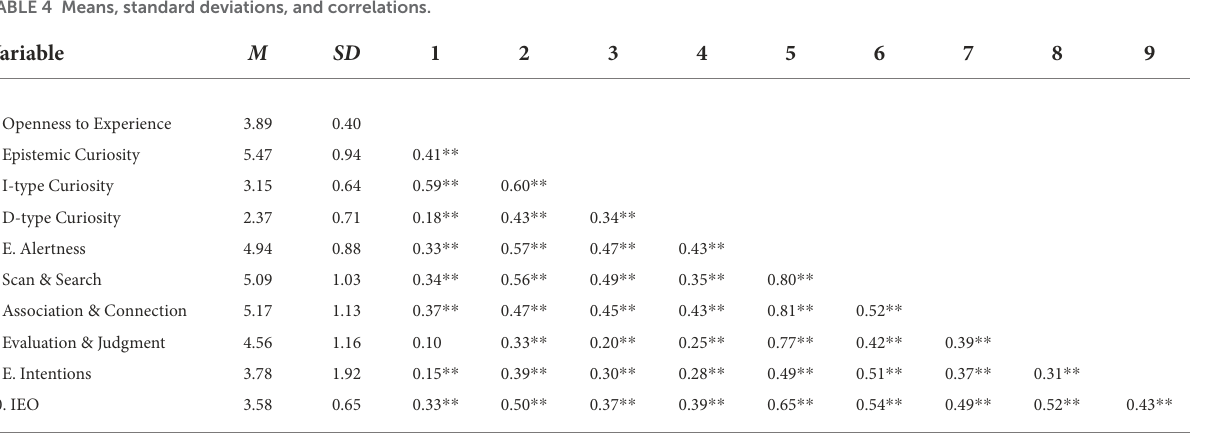
TABLE 4 Means, standard deviations, and